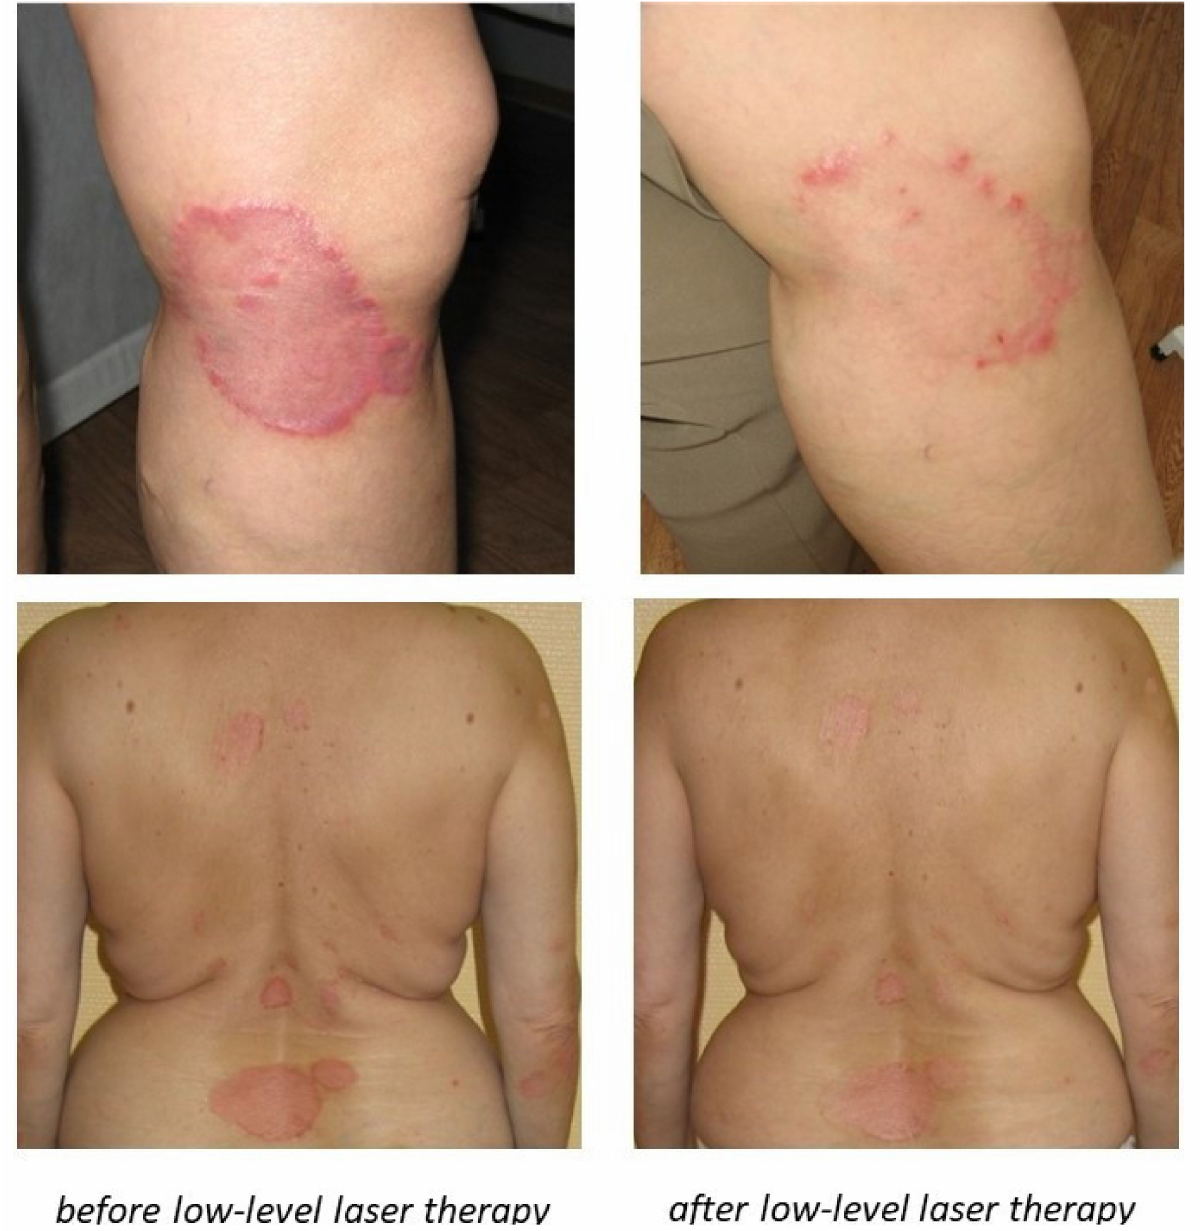
Figure 5. Visual positive effect after low-level laser therapy. Reduction of psoriatic skin inflammation was